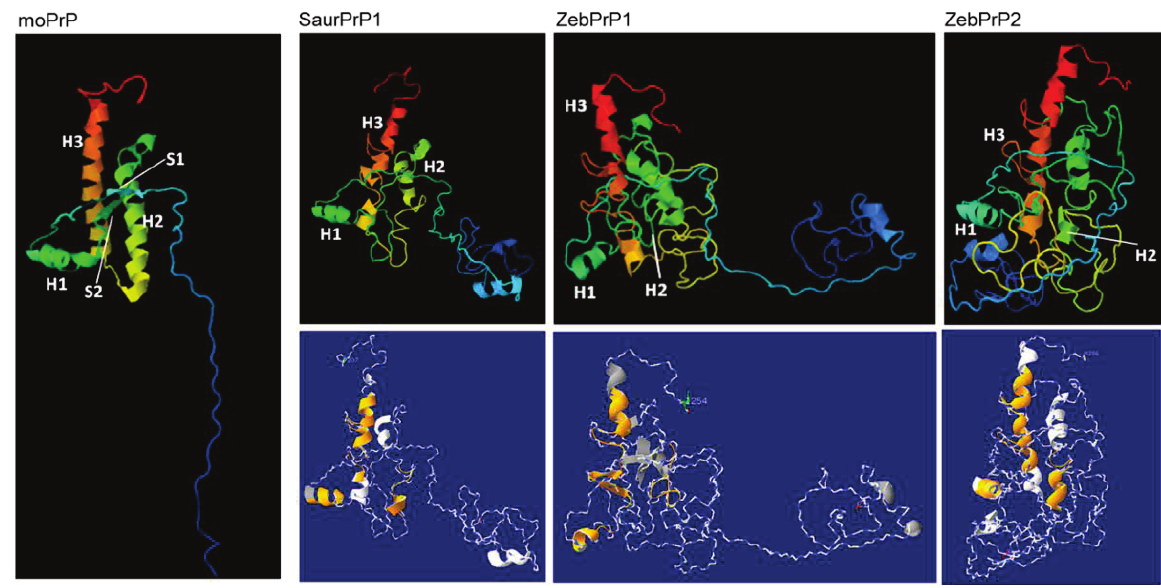
Figure 10. Structural prediction models corresponding to the C -terminal regions of the murine (moPrP) and the three piscine PrP proteins under study (SaurPrP, ZebPrP1, ZebPrP2). The well-defined secondary structure elements of murine PrP are shown (H1, H2, H3: helices 1, 2 and 3; S1, S2: sheets 1 and 2). Simplified views of the piscine models, highlighting (in orange) regions corresponding to murine PrP secondary structure elements are shown in blue